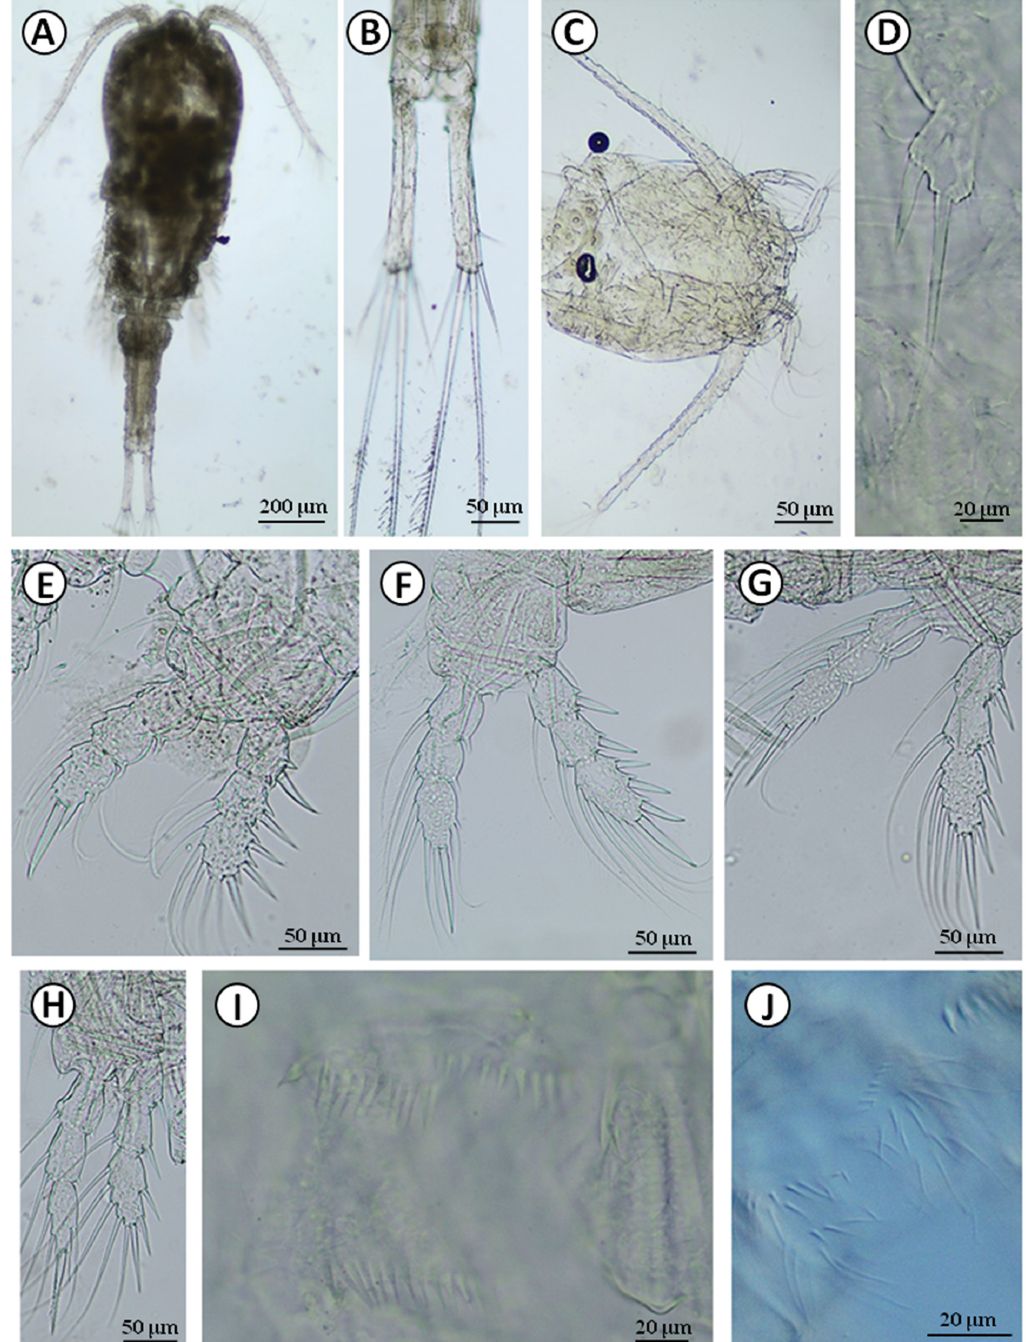
Figure 3. Cyclops furcifer : A —habitus; B —furcal branches; C —cephalothorax with antennule (A1) and antenna (A2); D —P5; E —P1; F —P2; G —P3; H —P4; I —coxopodite of P4; J —coupler of P4.